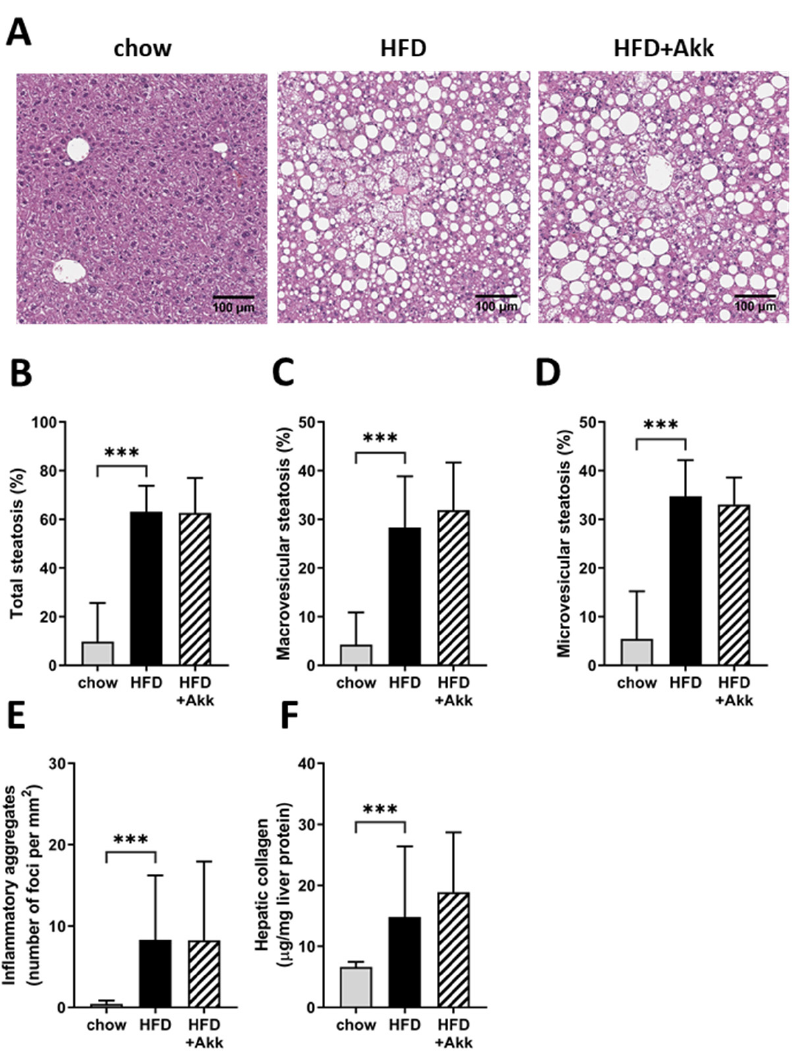
Figure 5. Heat-inactivated A. muciniphila does not affect development of non-alcoholic steatohepatitis or hepatic fibrosis. Ldlr − / − .Leiden mice were fed a chow reference diet (chow) or a NASH-inducing high-fat diet without (HFD) or with supplementation of heat-inactivated A. muciniphila (HFD + Akk) for 28 weeks. ( A ) Representative photo-micrographs of HE-stained cross sections of the liver; ( B ) total steatosis; ( C ) macrovesicular steatosis; ( D ) microvesicular steatosis; ( E ) hepatic inflammation; ( F ) hepatic collagen content. Data shown are mean ± SD. *** p < 0.001 vs. HFD. Table 3. Plasma bile acids are not affected by heat-inactivated A. muciniphila.